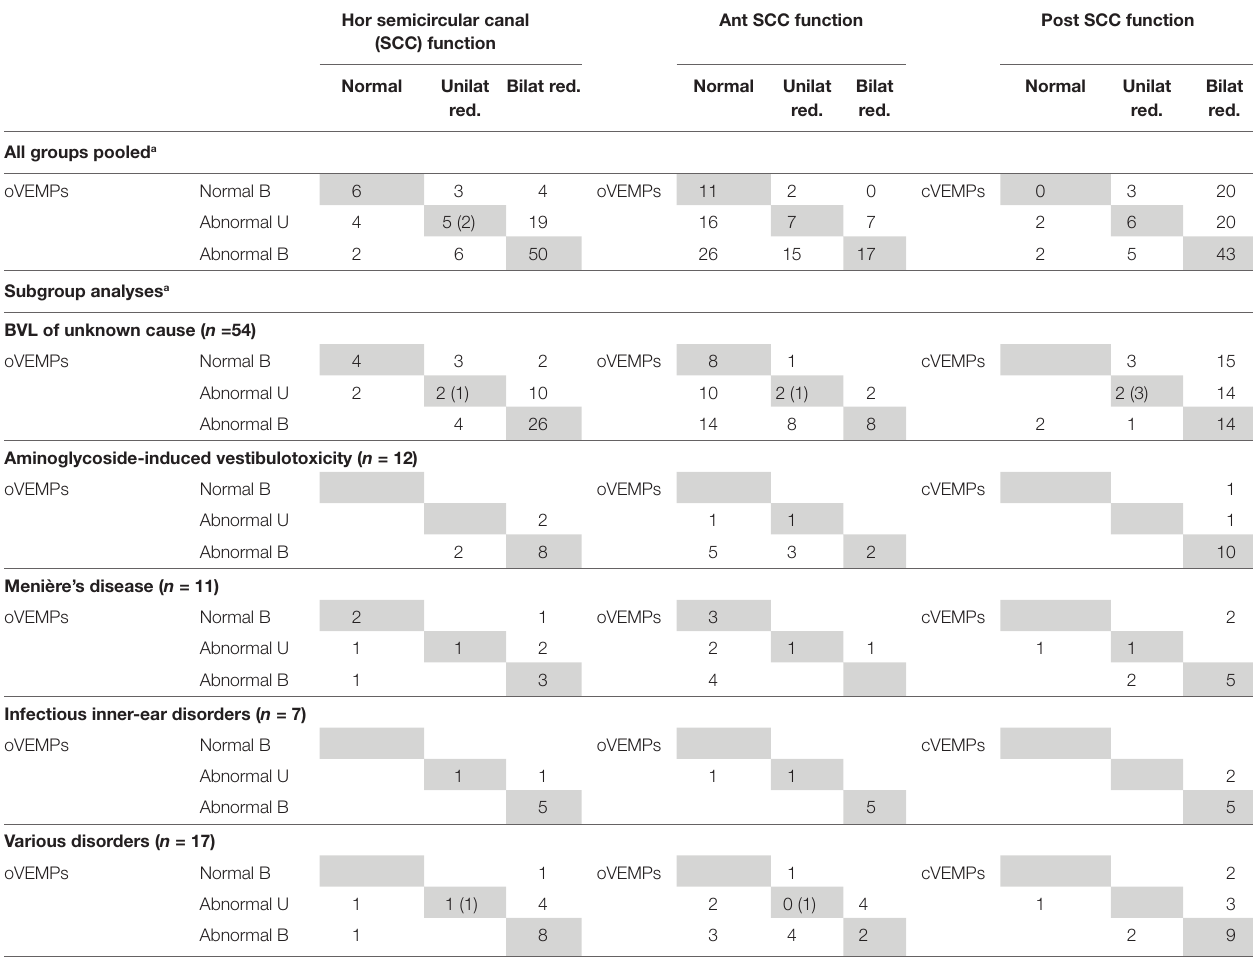
TaBle 8 | All bilateral vestibular loss (BVL) cases with vHIT, ocular vestibular-evoked myogenic potentials (oVEMPs) and cervical vestibular-evoked myogenic potentials (cVEMPs) ( n =